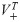
Achieving E/I cell ratio.(A) A subnetwork showing the connectivity and RFs in the network implementation of Eq (8). The excitatory connection weight from Ei to the inhibitory interneurons Ij is −⟨ϕ
i, ϕ
j⟩ (forming the (i, j)th entry of G
+ in Eq (8)). The recurrent connections from the inhibitory neurons back to the excitatory ones (in green) are one-to-one (rows of the identity matrix). This implementation results in an inhibitory population with similar size and orientation tuning properties as the presynaptic excitatory cells. (B) A stylized sub-network showing the network implementing Eq (9). The RFs (mapped out by sparse dots [17]) of the interneurons are dot-like, with extreme localization and no orientation tuning. (C) A stylized sub-network implementing Eq (11). The interneurons receive excitatory inputs weighted by the corresponding row in V+T, adjust the gain by the corresponding diagonal entry in Σ, and projects back to the excitatory population with connectivity weights determined by the corresponding row in U
+. These interneurons receive dense input from many principal cells and have unstructured receptive fields, again with no discernible orientation tuning.